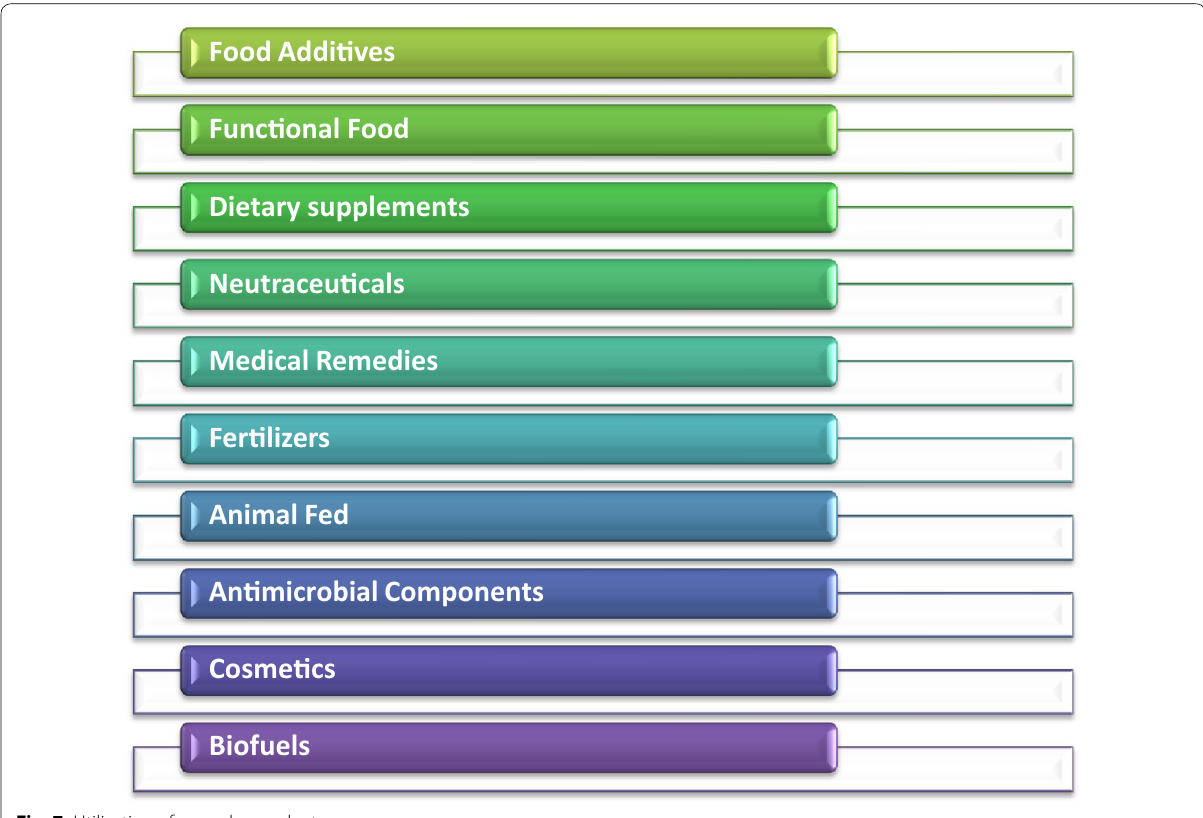
Fig. 7 Utilization of grape by